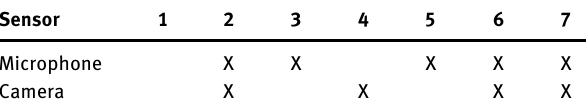
Table 1: Types of privacy risks in relation to sensors: ( 1 ) privacy of the person; ( 2 ) privacy of action and behavior; ( 3 ) privacy of com - munication; ( 4 ) privacy of data and image; ( 5 ) privacy of thoughts and feelings; ( 6 ) privacy of location and space; ( 7 ) privacy of